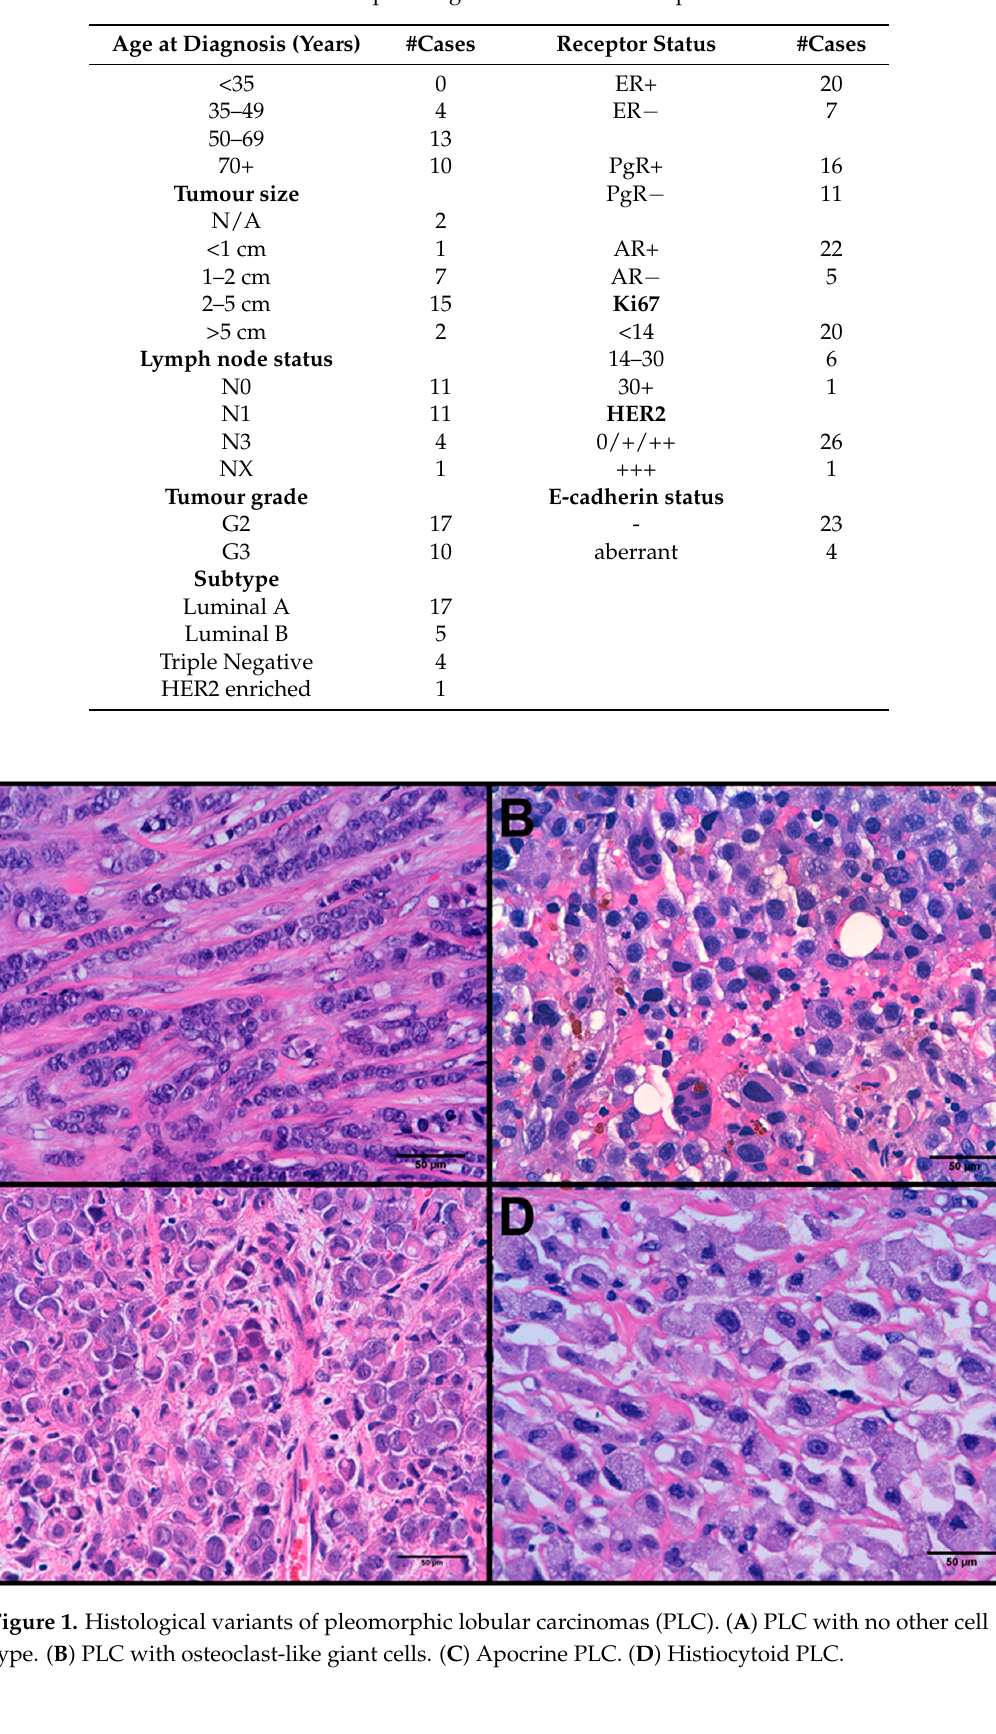
Table 1. Clinicopathological features of the 27 patients.